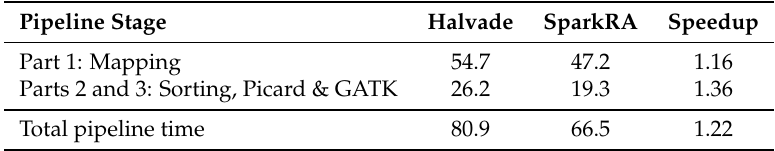
Table 3. Pipeline computation time (in minutes) results and speedup of SparkRA compared to Halvade-RNA running on the SURFsara